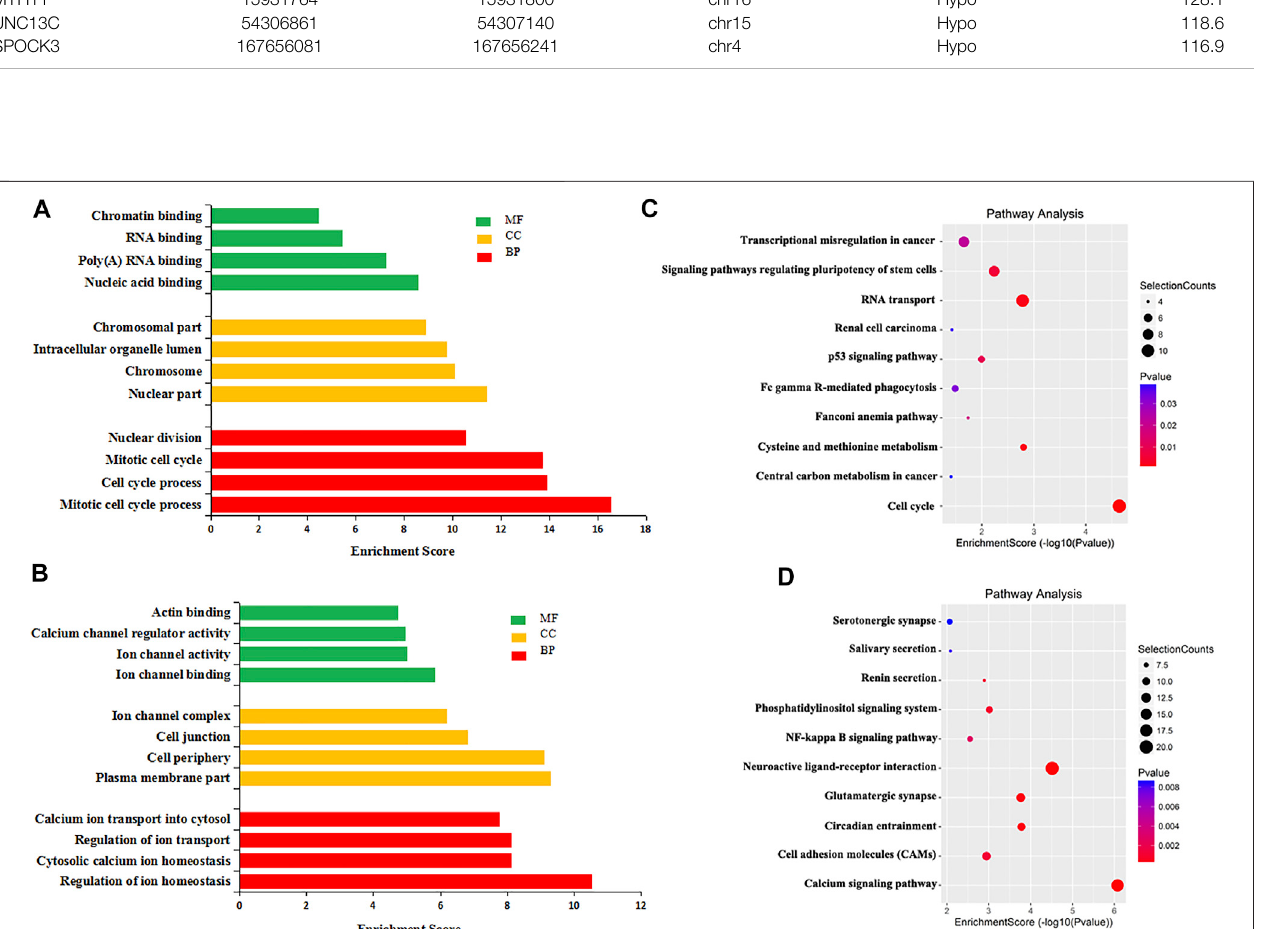
Frontiers in Cell and Developmental Biology |